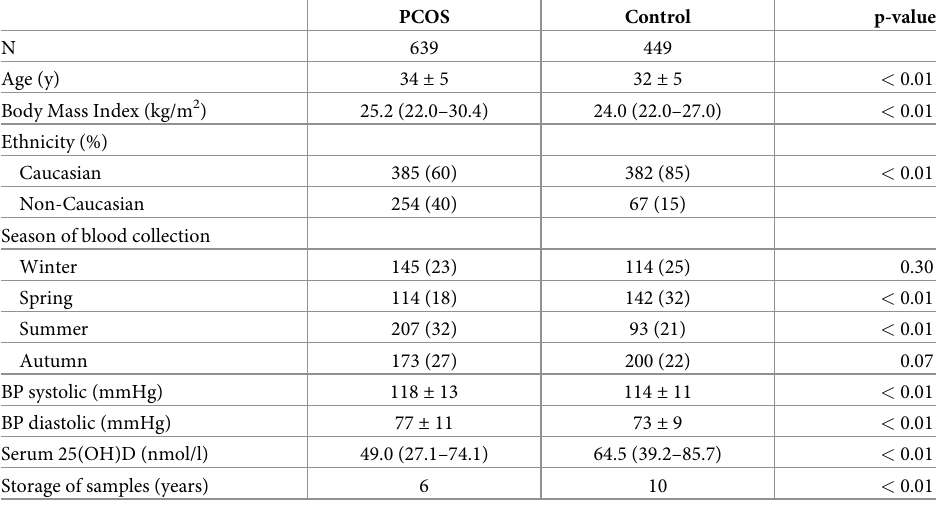
Table 1. Baseline characteristics of PCOS and fertile control